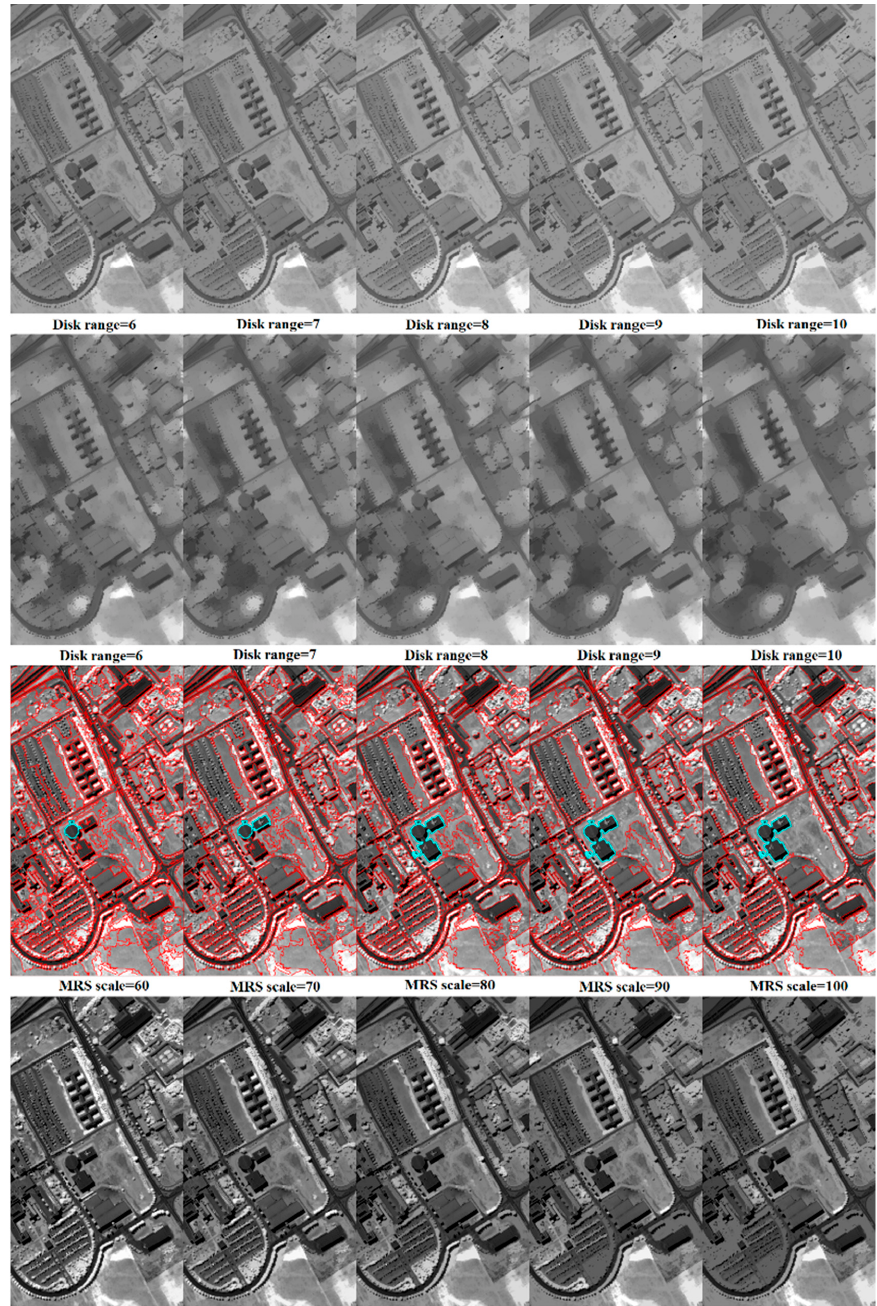
Figure 3. Examples of opening by reconstruction (OBR) (row 1), opening by partial reconstruction (OBPR) (row 2), multiresolution segmentation (MRS) objects (row 3) and object-guided opening by reconstruction (OOBR) (row 4) with di ff erent parameter sets from the second principal component of the Pavia University